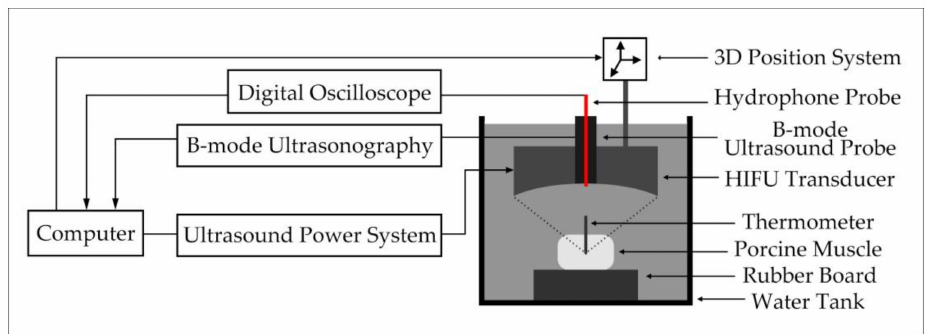
Figure 3. HIFU irradiation experiment